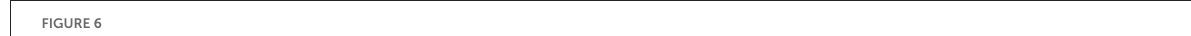
FIGURE6 deposition in VICs normalized to the protein content. (C,D) Representative bands of Western blotting and semiquantitative analysis of RUNX2, BMP2 protein in VICs. (E,F) Transcriptional expression of ferroptosis DEGs expressed as fold changes. (G,H) Heatmap of ferroptosis DEGs expression over time shown as fold changes. The row label represents gene name, the column label represents subgroup, and the vertical colormap in the right represents fold changes. (I–M) Representative bands of Western blotting and semiquantitative analysis of IL-6, HMOX-1, HIF-1 α , BID, and PRKAA2 protein in VICs, respectively. n = 3–4 per group for in vitro experiments. Values shown were mean ± SD. * p < 0.05 vs. Ctrl or Ctrl-day 0; ** p < 0.01 vs. Ctrl or Ctrl-day 0, # p < 0.05 vs.